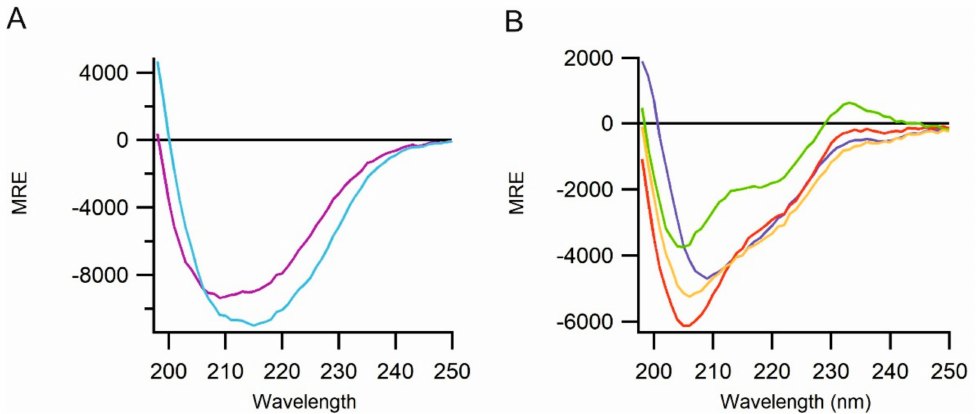
Figure 4. Far-ultraviolet circular dichroism (CD) spectra for the purified proteins. ( A ) The spectra of mucin 2 (V36-G389; light blue) and alpha tectorin (P707-P981; purple). ( B ) Spectra of constructs of region 3 of perlecan; G503-Q874 (dark blue), S762-R1158 (red), R1158-T1672 (green) and G503-T1672